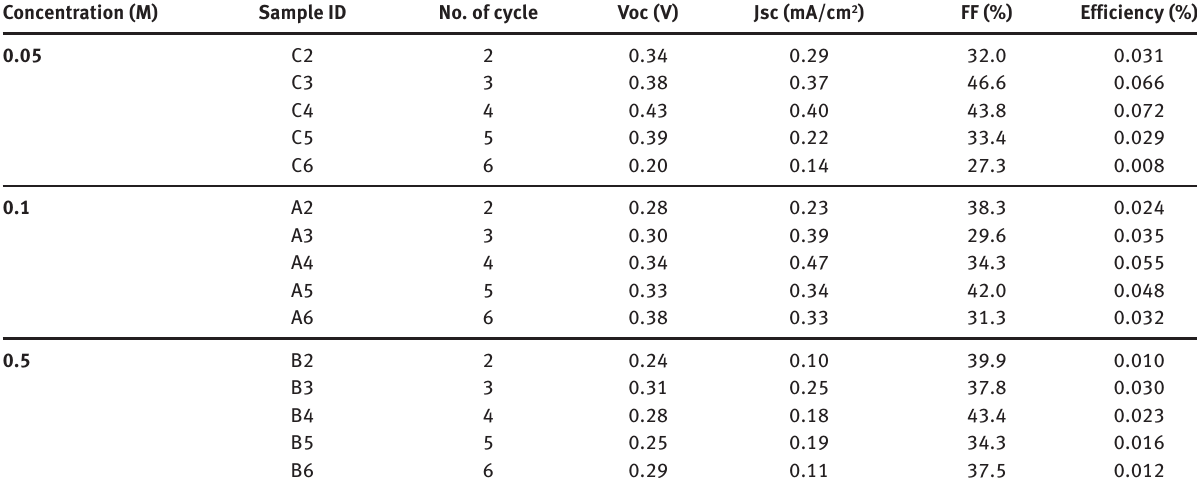
Table 2: Relationship between concentration, number of SILAR cycles, and V Concentration (M) Sample